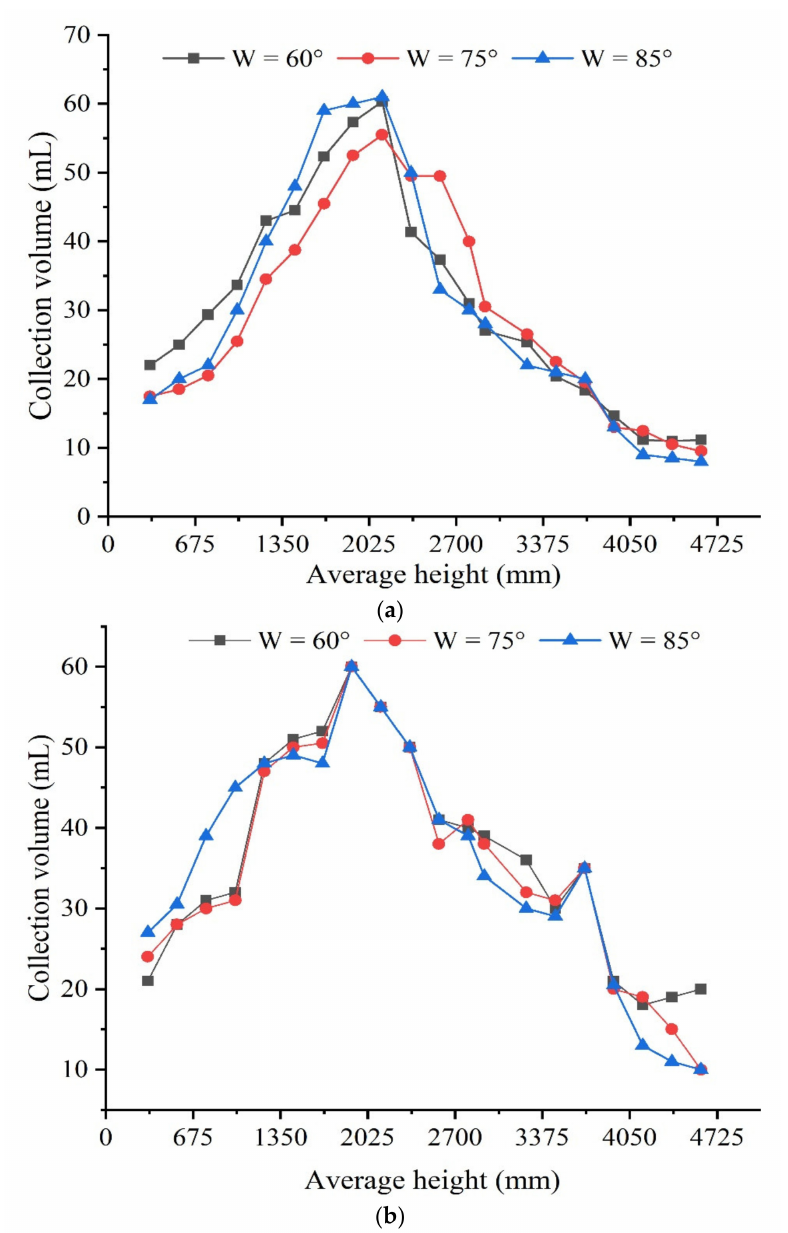
Figure 7. Influence of the spray angle on the collection volume at different spray distances (N = 2400 r/min). ( a ) Influence of the spray angle on the collection volume (L = 1.0 m). ( b ) In- fluence of the spray angle on the collection volume (L = 2.0